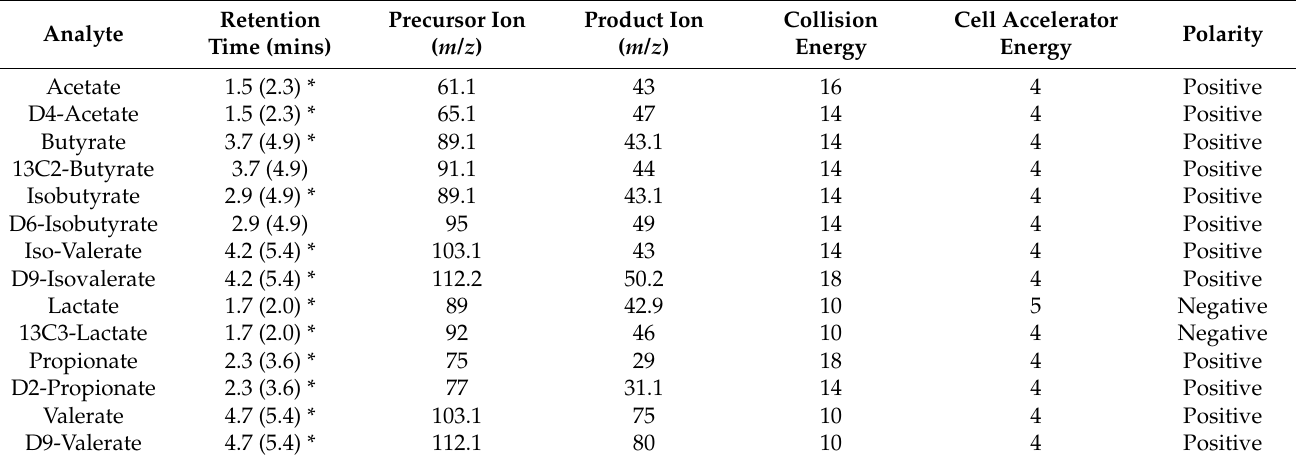
Table 1. LC-MS/MS parameters of